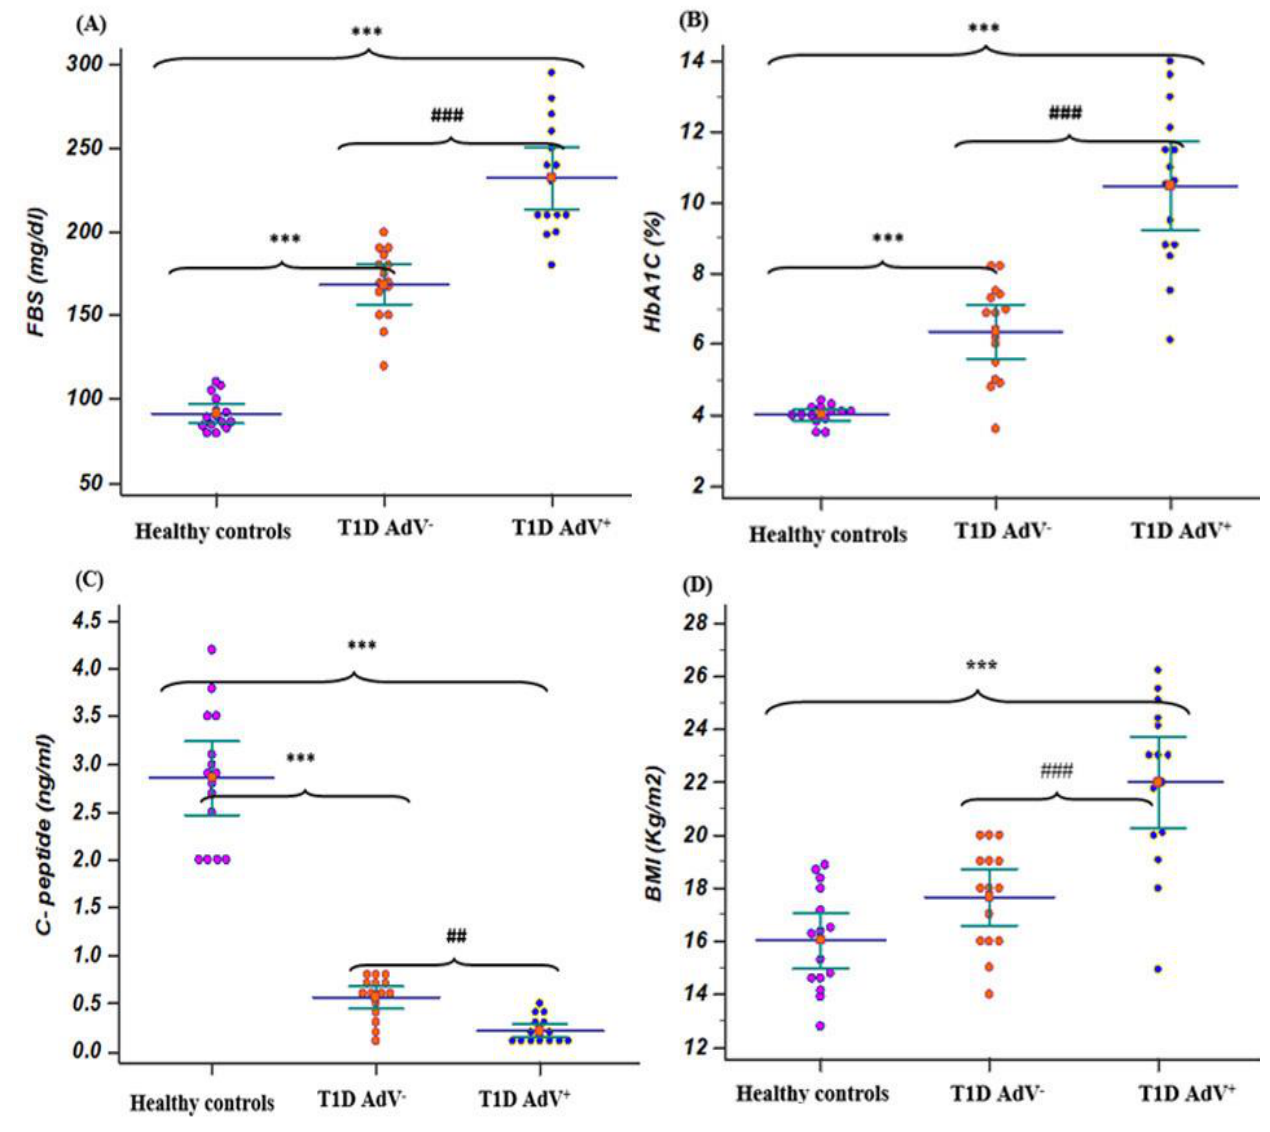
Figure 1. Fasting blood sugar (FBS), hemoglobin A1C (HbA1c), C- peptide, and body mass index in T1D — negative AdV (PCR and antibodies) and T1D — AdV positive (PCR) groups in comparison to healthy control. ( A ) FBS, control group: mean 91.4 ± 4.4 and range 80 – 110; T1D AdV - : mean 168.7 ± 10.65 and range 120 – 200; and T1D AdV + : mean 232.2 ± 16.78 and range 180 – 295 ; ( B ) HbA1C, control group: mean 4 ± 0.25 and range 3.5 – 4.4 ; T1D AdV - : mean 6.36 ± 0.68 and range 3.6 – 8.2 ; and T1D AdV + : mean 10.46 ± 1.13 and range 6.1 – 14; ( C ) C-peptide, control group: mean 3.91 ± 0.48 and range 2.7 – 5.6 ; T1D AdV - : mean 0.56 ± 0.219 and range 0.1 – 0.8 ; and T1D AdV + : mean 0.213 ± 0.135 and range 0.1 - 0.5; and ( D ) BMI, control group: mean 17.3 ± 2.2 and range 12.8 – 30 ; T1D AdV - : mean 16.46 ± 1.15 and range 13 – 20 ; and T1D AdV + : mean 22 ± 1.55 and range 14.9 – 26.2. Values were considered significantly different at *** p < 0.001 versus healthy controls, and ### p < 0.001 T1D — AdV-versus T1D — AdV PCR + children. The levels of FBS and HbA1c% were associated with a significant ( p < 0.001) increase